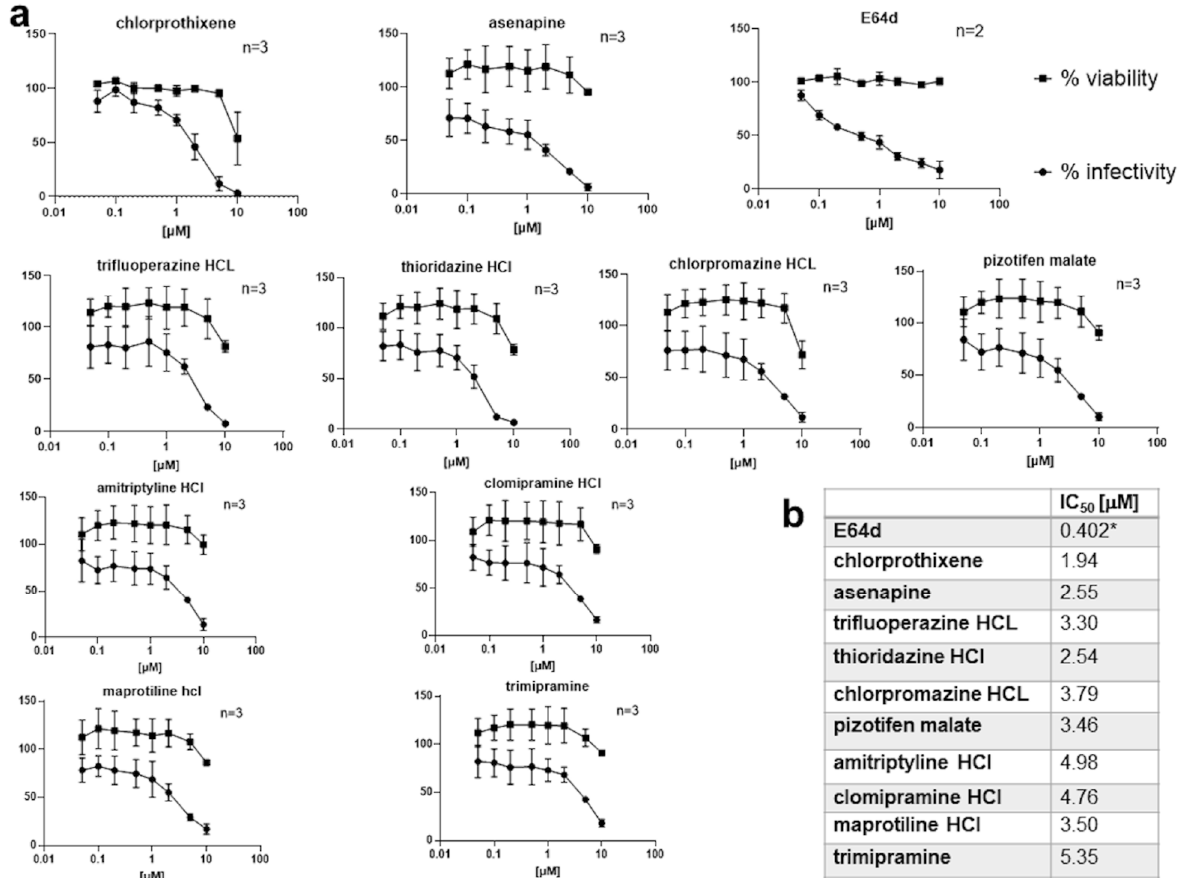
Figure 3. Dose–response curves of kite-shaped molecules in SARS-CoV-2-S inhibition. Mouse leukemia virus pseudotyped with spike protein (S) from severe acute respiratory syndrome coronavirus-2 was used to infect 293T-ACE2 cells in 96-well plates for 48 h in the presence of serial doses of the drug, as indicated, with 1 h pre-treatment. ( a ) Infectivity was measured as luciferase activity and expressed as % infectivity to infected, own solvent control (dimethyl sulfoxide, ethanol or water). Viability was measured by XTT assays in uninfected cells and expressed as % viability to un-infected solvent control (dimethyl sulfoxide, ethanol or water). Data are presented as mean ± SD of two to three repeats, as indicated. The square symbols are for cell viability (% of control) and the round symbols are for infectivity by the pseudovirus (% of control). ( b ) Summary of IC 50 values. * The IC 50 of E64d was obtained by interpolation from the dose–response curve.